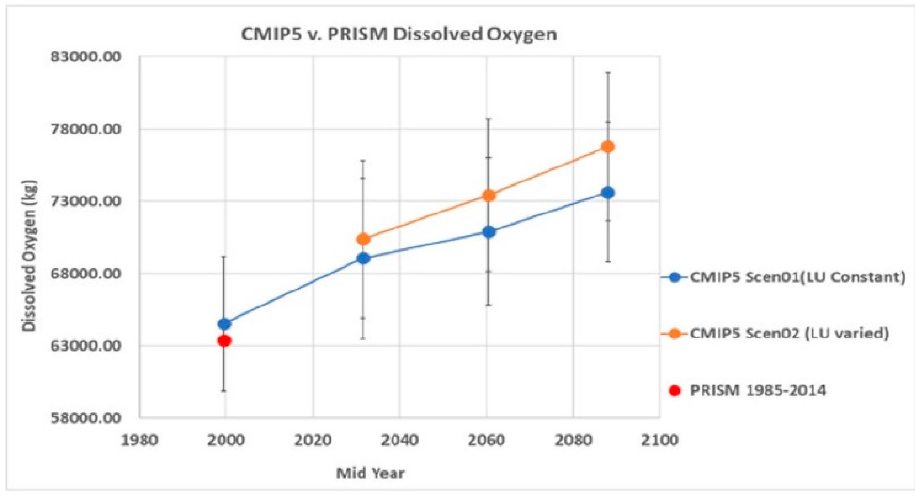
Figure 11. PRISM vs. average of 20 CMIP5 GCMs dissolved oxygen (2018–2100).